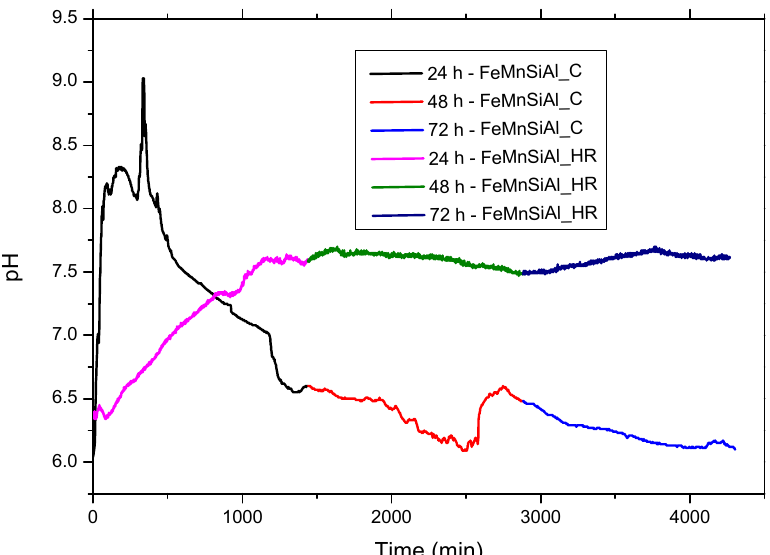
Figure 5. The pH variation values recorded during 72 h of immersion in Ringer’s solution for the C and HR FeMnSiAl samples.